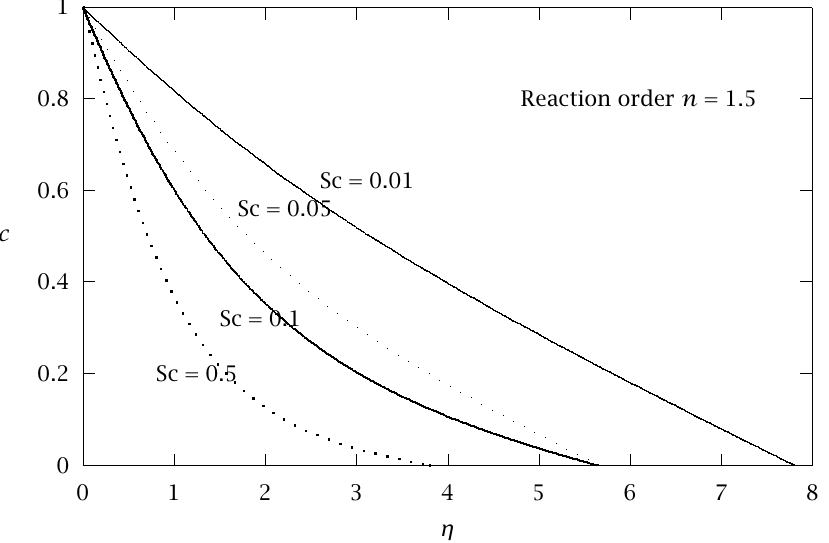
Figure 5.8 . Concentration profiles for n = 1 . 5.